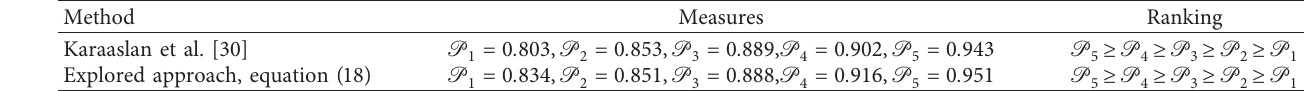
Table 3: Comparison of the explored work with existing work.